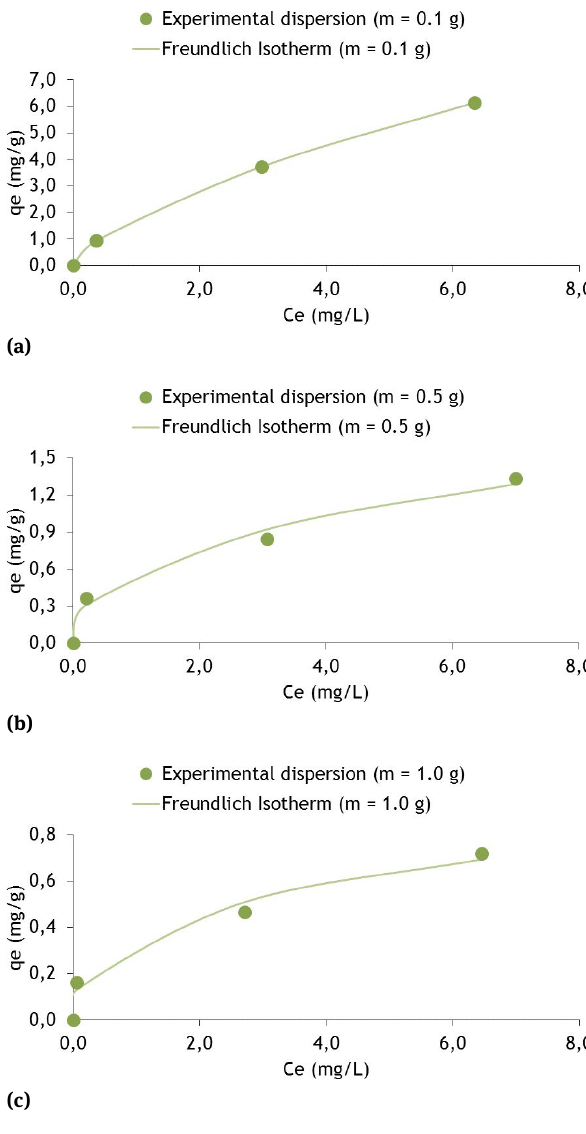
Figure 7: Sorption isotherms for the Freundlich model with Zn and soil masses of 0.1 g (a), 0.5 (b) and 1.0 g (c)